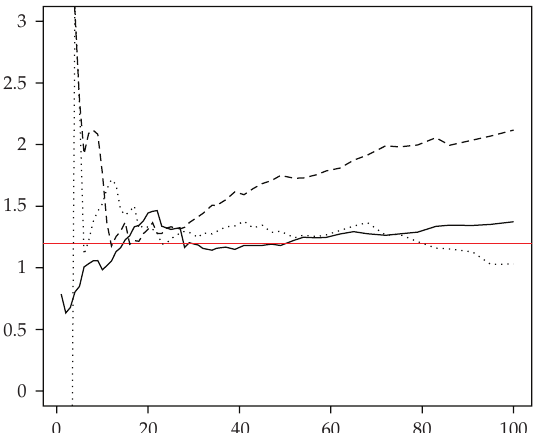
Figure 2: Plots of Hill estimators, as functions of the number of extreme statistics, (cid:5) α (cid:2) solid line (cid:3) , (cid:5) α R (cid:2) dashed line (cid:3) , and (cid:5) α L (cid:2) dotted line (cid:3) of the characteristic exponent α of a stable distribution skewed to the left, based on 1000 observations with 50 replications. The horizontal line represents the true value of α (cid:4) 1 . 2.